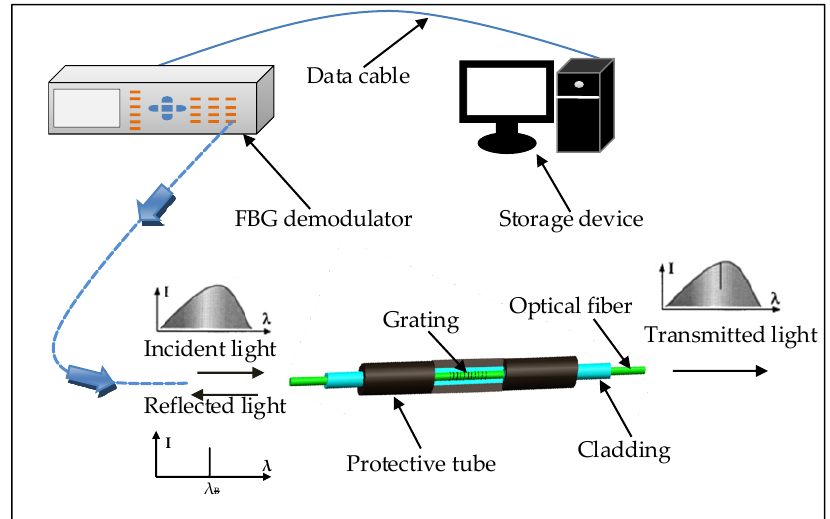
Figure 1. Working principle diagram of Fiber Bragg Grating (FBG) sensors.